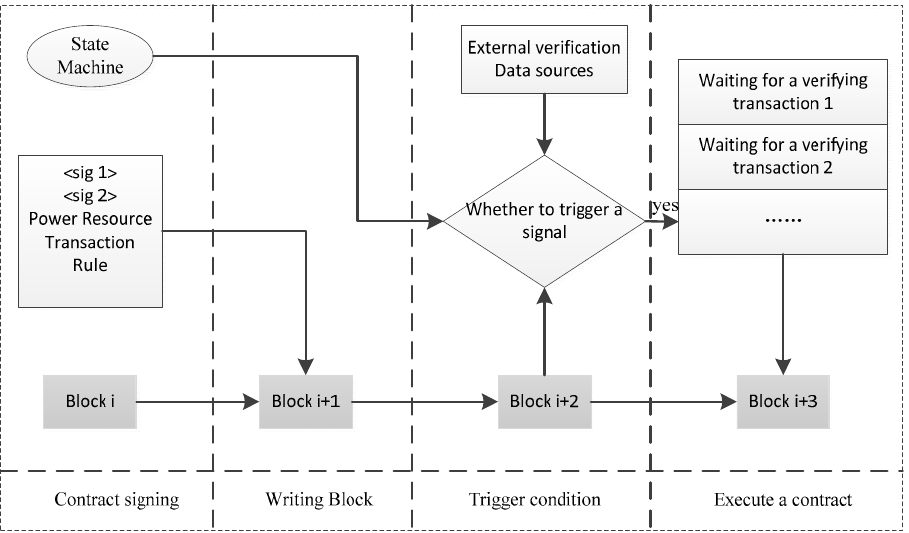
Figure 13. Model diagram of a smart contract for transaction and settlement of a microgrid